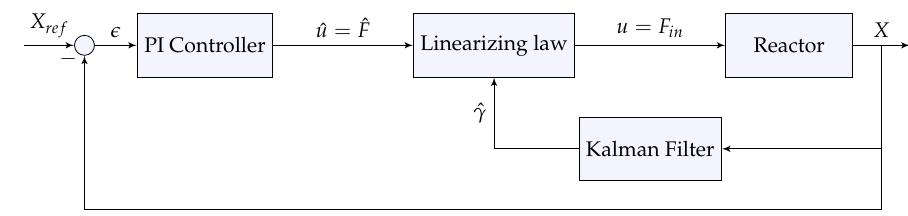
Figure 2. GMC combined with the Kalman